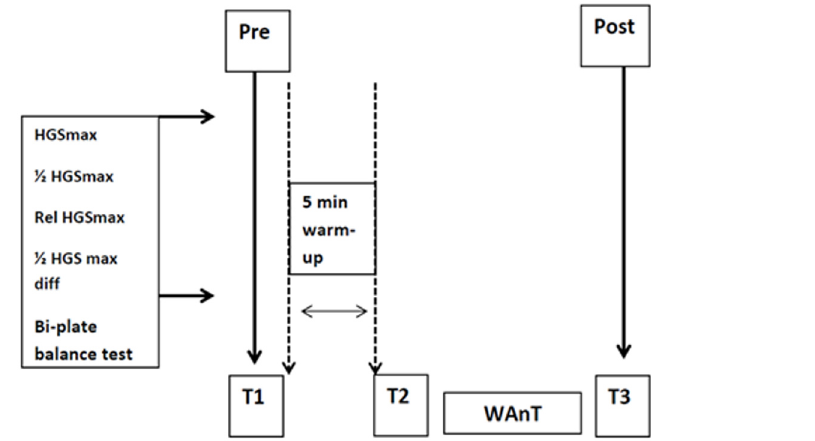
Fig 1. Diagram of tests conducted in the study.